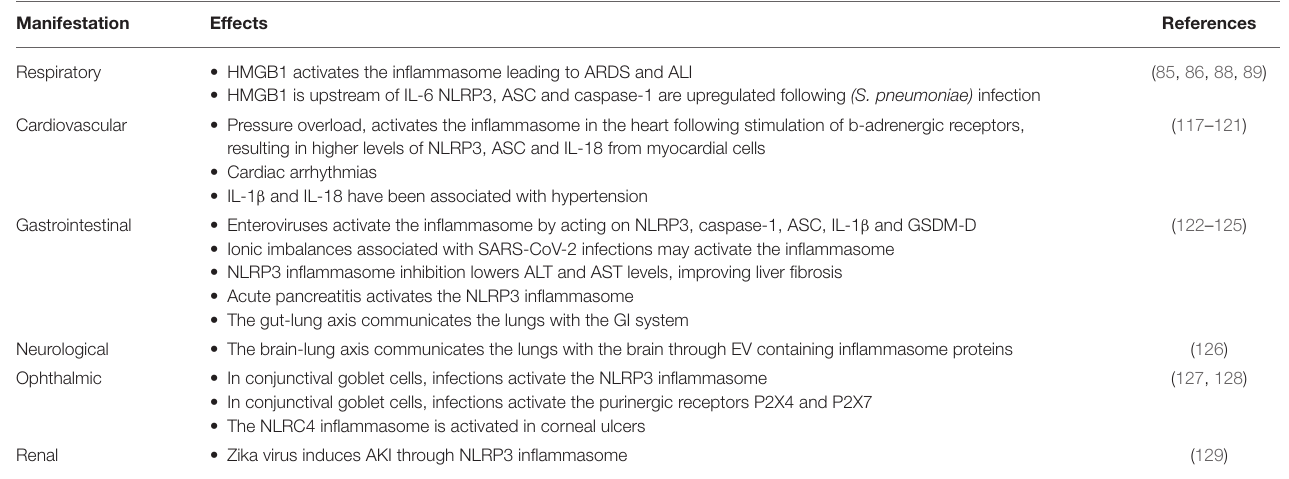
TABLE 2 | Potential effects of inflammasome activation on COVID-19 manifestations.